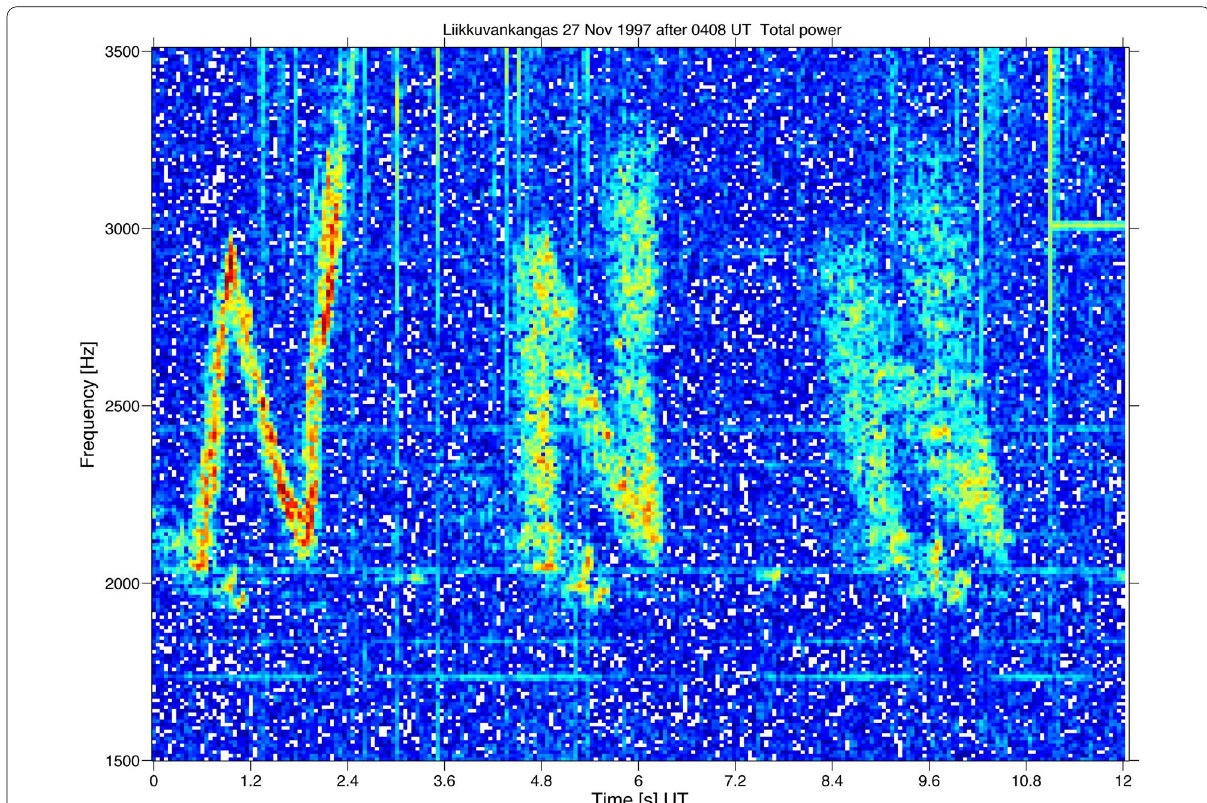
Fig. 6 Spectrogram of N-shaped VLF emission as observed at a receiving station in Northern Finland. Note the repeated reflections and dispersion of the N emission